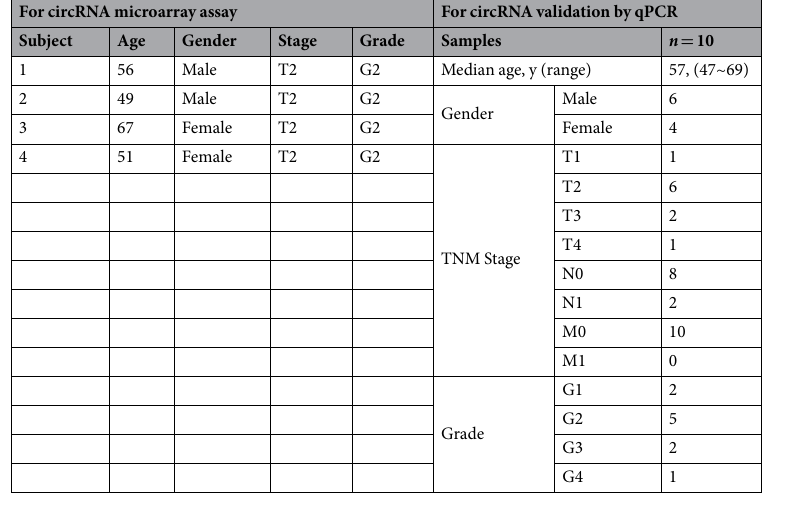
Table 3. Clinical pathological characteristics of study